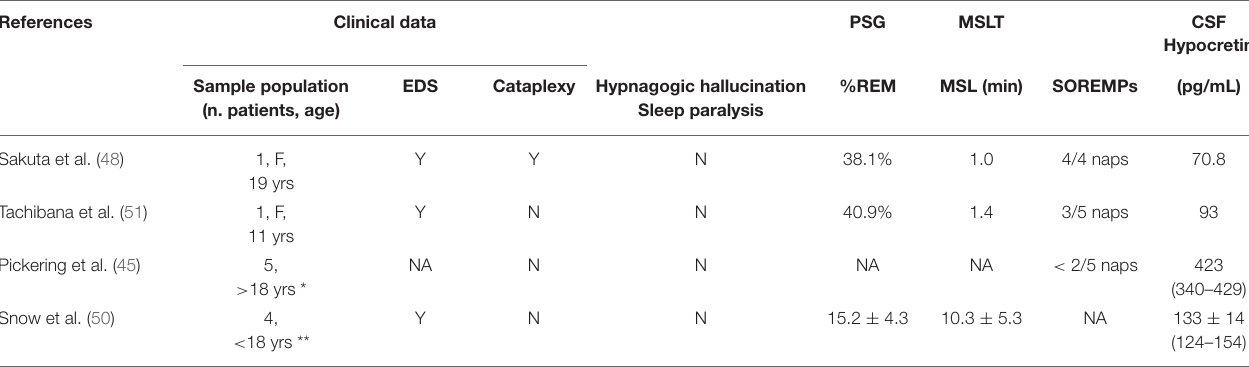
TABLE 2 | Clinical and neurophysiological features of patients with CP in whom CSF hypocretin assay was